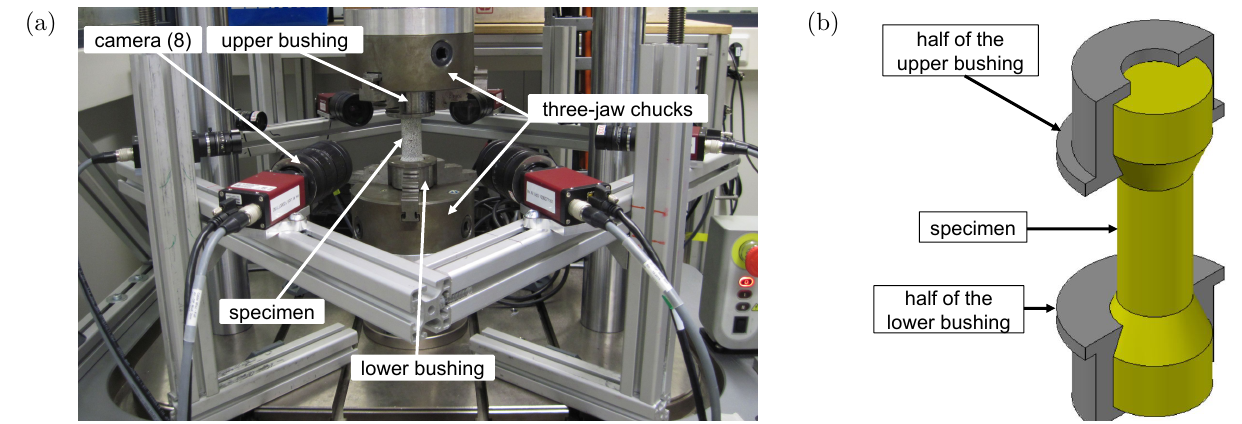
Figure 1. Set-up of the experiments (a) and cutaway of the bushing on the specimen